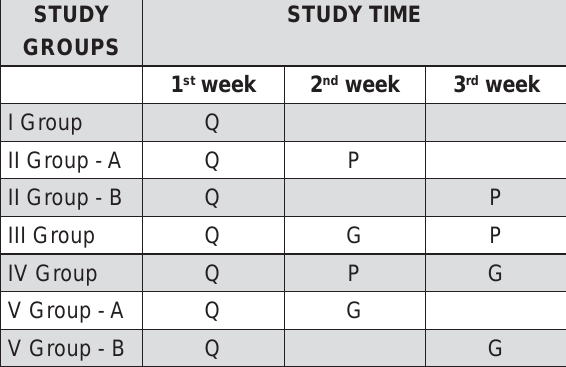
Figure 1- Experimental procedure performed in the various groups. (Q - quarantine, P - hydrogen peroxide administration; G - non-tumoral gastric pathology